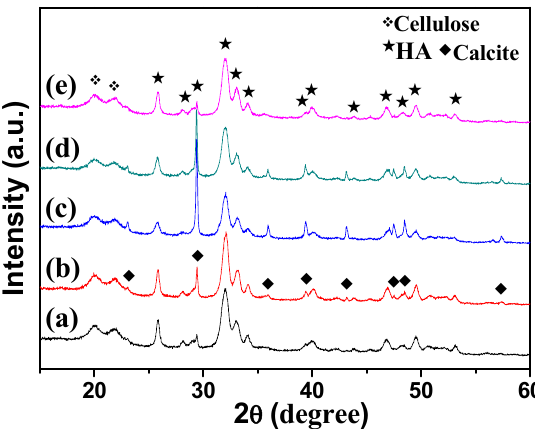
Figure 2. X-ray powder diffraction (XRD) patterns of the cellulose/HA nanocomposites prepared by microwave-assisted hydrothermal method at 150 °C for 10 min ( a , c – e ) and 60 min ( b ) using different phosphorus sources: ( a , b ) NaH 2 PO 4 ·2H 2 O; ( c ) ATP; ( d ) CP; ( e ) FBP.